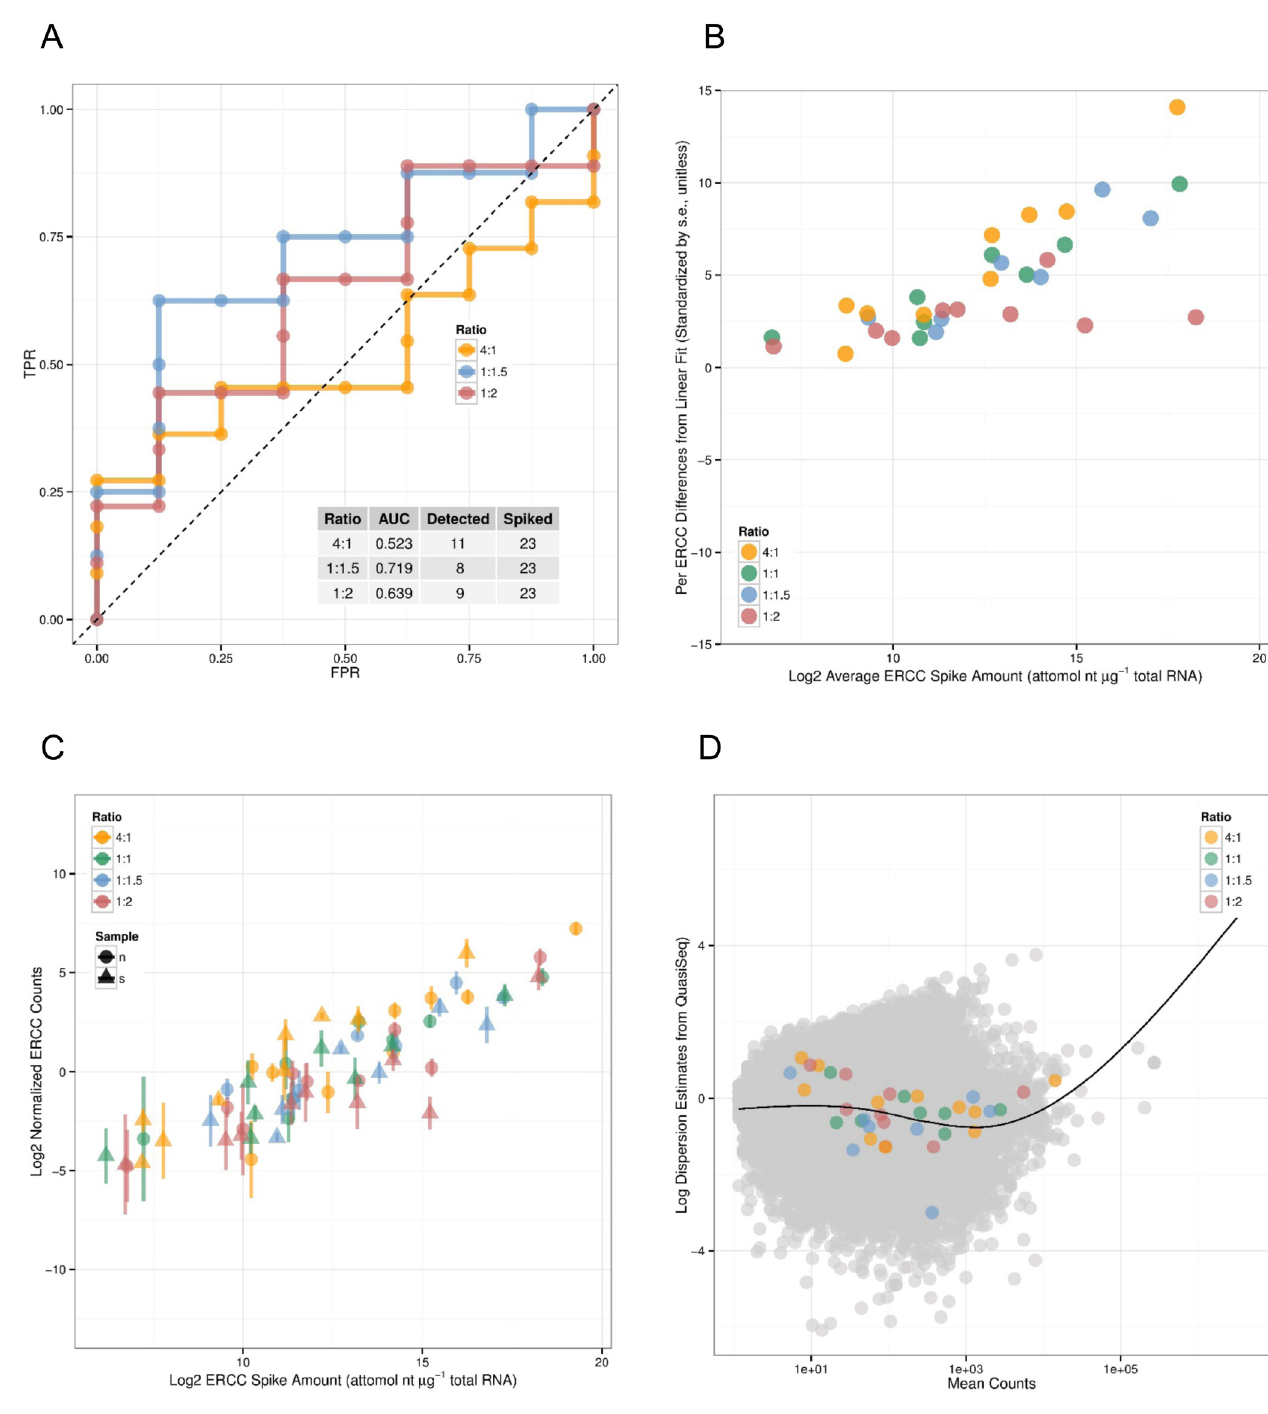
Figure 1. Arkas-Analysis ERCC spike-in Controls Report. A ) The Receiver Operator Characteristic plot of (detected) ERCC ratios in gene expression experiments. The X-axis shows the False Positive Rate, the Y-axis shows True Positive Rate. B ) and C ) shows the dynamic range of abundances of ERCC RNA amounts with a linear model fit, and ERCC RNA counts. D ) shows a dispersion of mean transcript abundances and the estimated dispersion.